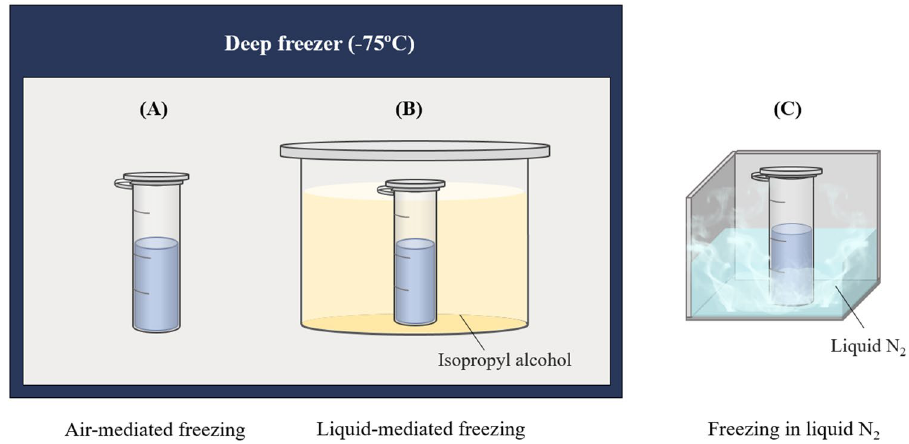
Figure 1. Schematic diagrams of the three different freezing methods. ( A ) Air-mediated freezing, ( B ) liquid- mediated freezing, and ( C ) freezing in liquid nitrogen (N 2